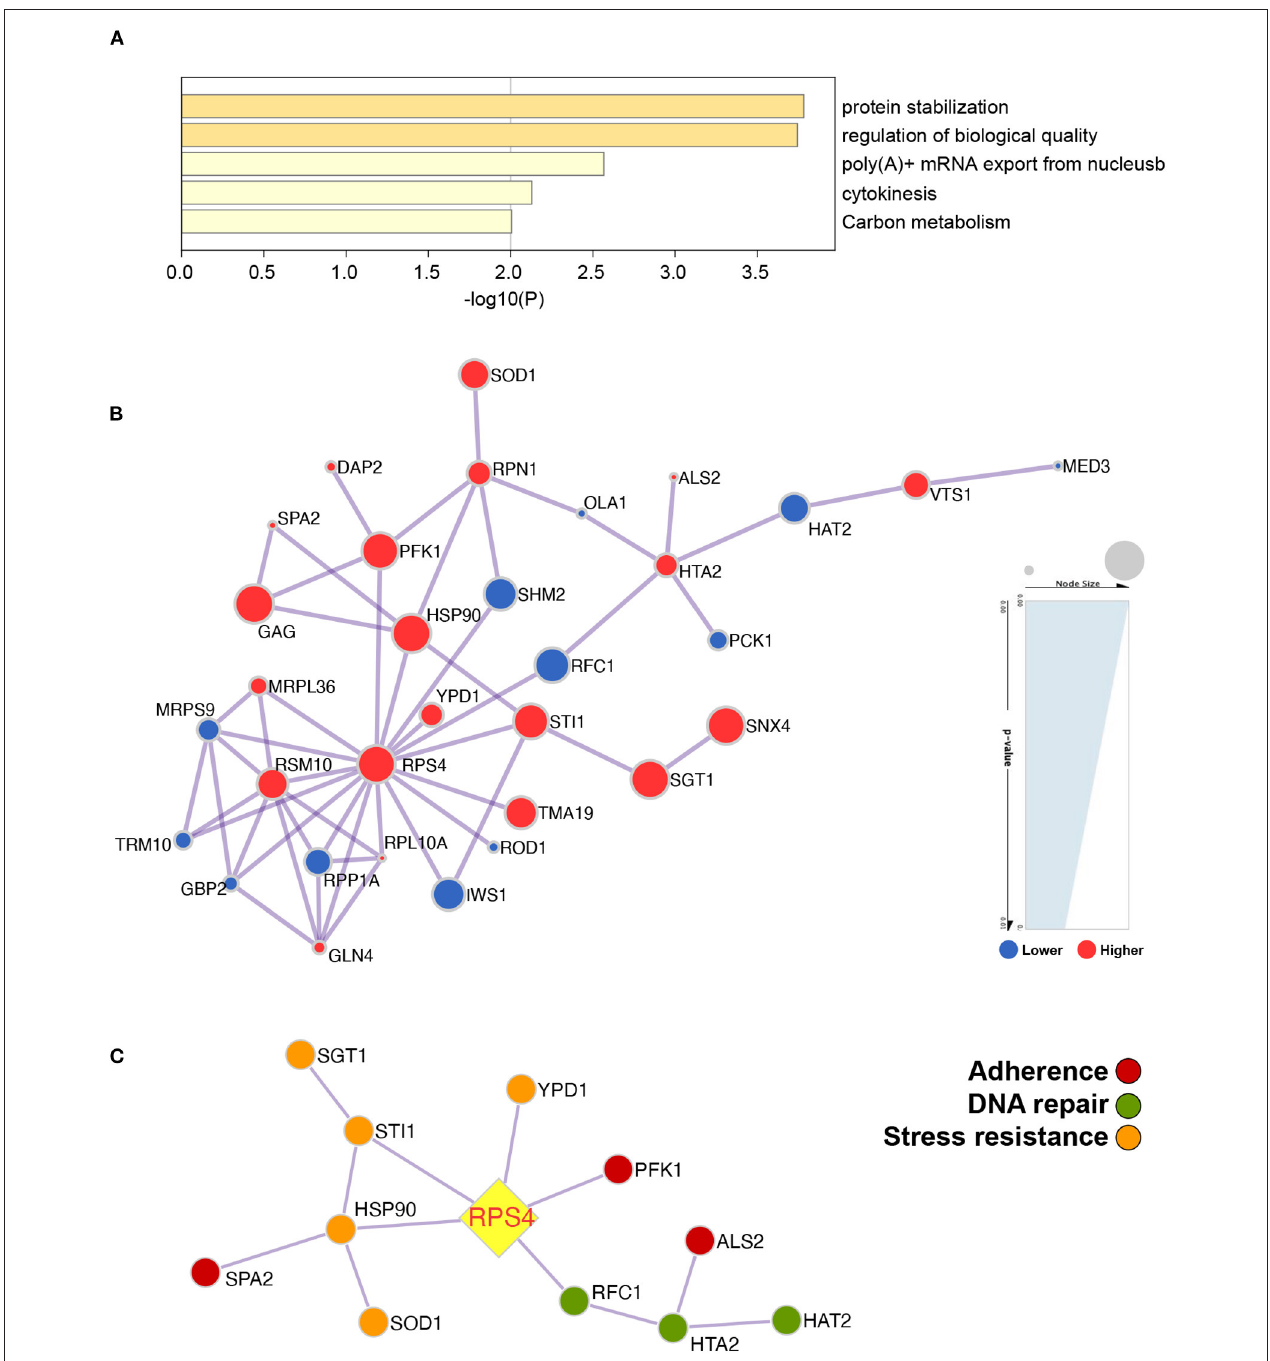
FIGURE 6 | The protein profile demonstrated that the metabolic pathways were significantly different between C. albicans clade 1 isolates and non-clade 1 isolates and that RPS4 was the key gene linked to the proteins influencing the pathogenicity of C. albicans . The differentially expressed proteins were enriched in the pathways of protein stabilization, regulation of biological quality, poly(A)+ mRNA export from the nucleus, cytokinesis, and carbon metabolism (A) . The network of the proteins that were expressed significantly differently between clade 1 and non-clade 1 isolates was analyzed (B) , and RPS4 was the key protein associated with the stress resistance (HSP90, SGT1, SOD1, STI1, and YPD1), adherence (ALS2, PFK1, and SPA2), and DNA repair (HAT2, RFC1, and HTA2) of C. albicans (C) . were significantly higher than those of non-clade 1 strains, except for MFG. This result suggested that MFG may be a better choice for the treatment of clade 1 strain